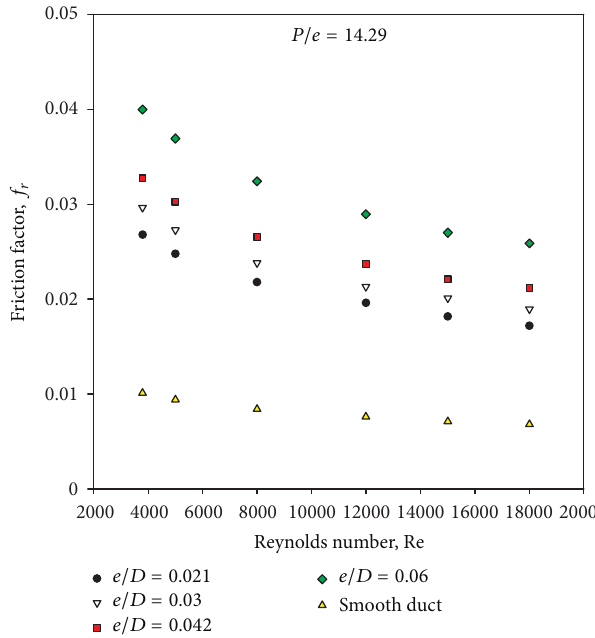
Figure9:VariationofaveragefrictionfactorwithReynoldsnumber.